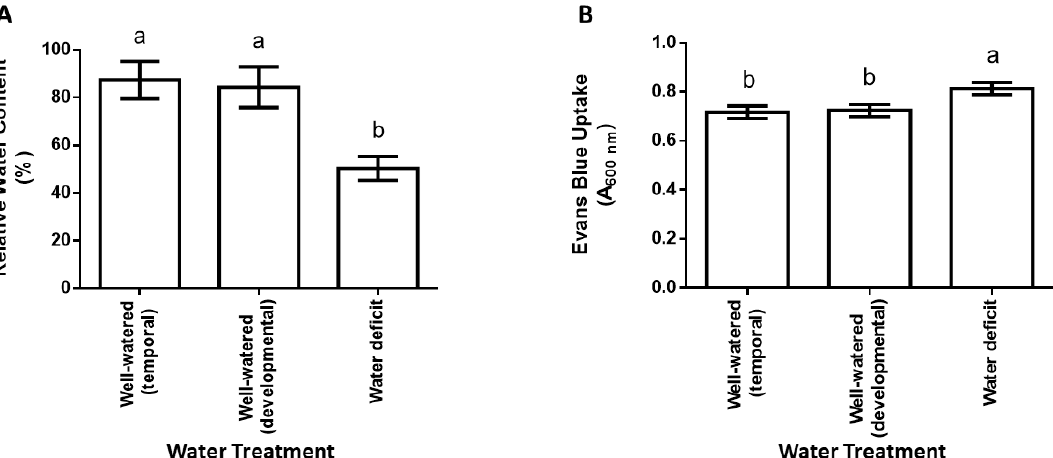
Figure 1. Effect of water deficit on relative water content ( A ) and cell death ( B ) in maize leaves. The third youngest leaf from three different plants in each treatment (well-watered temporal and developmental controls, water deficit) was used. Data are means ± SD from three independent experiments, where different letters above error bars indicate means that are significantly different ( p ≤ 0.05).